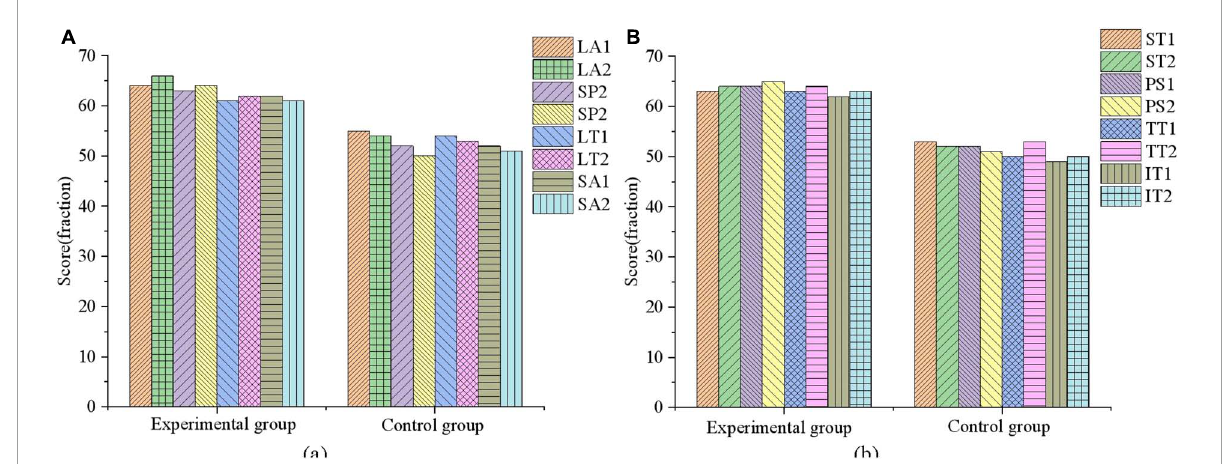
FIGURE18 Comparison of mental health evaluation results between experimental group and control group. (A) LA, SP, LT, and SA; (B) ST, PS, TT, and